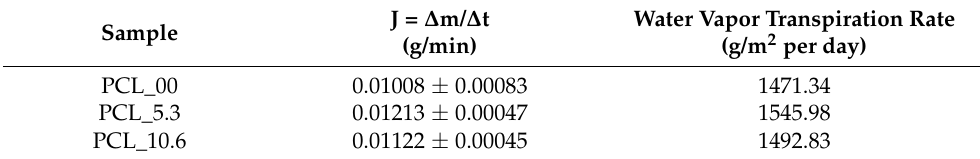
Table 5. The water vapor transpiration rates (WVTR) of PCL/ P. major